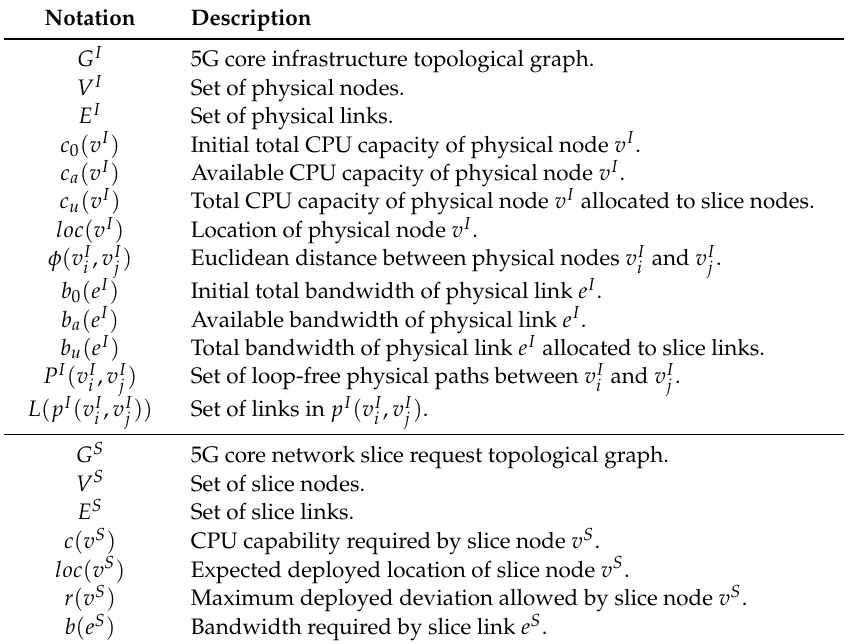
Table 1. System model